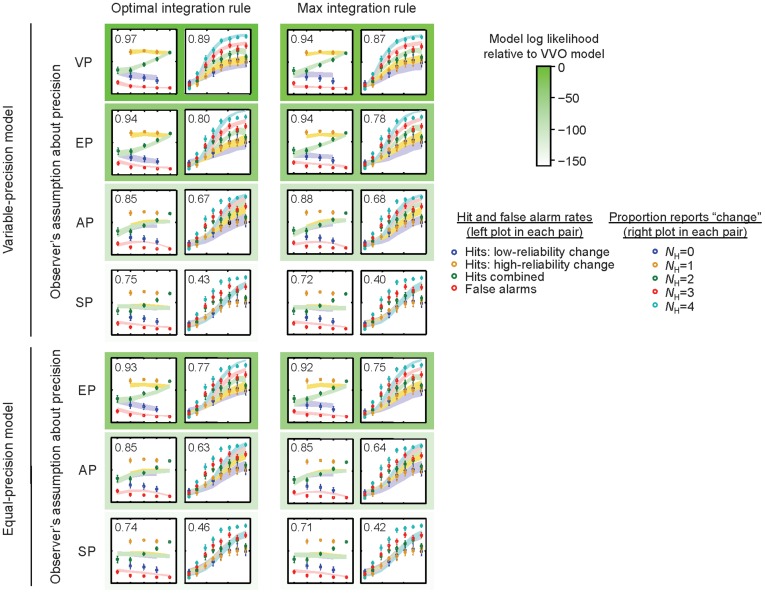
Fits of all 14 models to the data in Fig. 1B-C (axis labels and scales as there).VP  =  variable precision; EP  =  equal precision; AP  =  average precision; SP  =  single precision. Error bars and shaded areas represent ±1 s.e.m. in the data and the model, respectively. The number in each plot is the R
2 of the fit (for the left plot in each pair, computed over false-alarm rates and unconditioned hit rates). Frame color indicates model goodness of fit relative to the winning model, as obtained from Bayesian model comparison (Fig. 4).